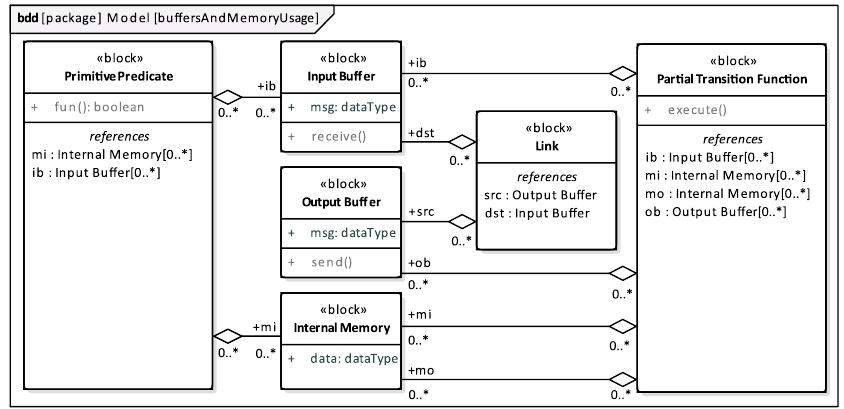
Figure 6. The utilisation of Buffers and Internal Memory by: Partial Transition Function, Primitive Predicate and Links.